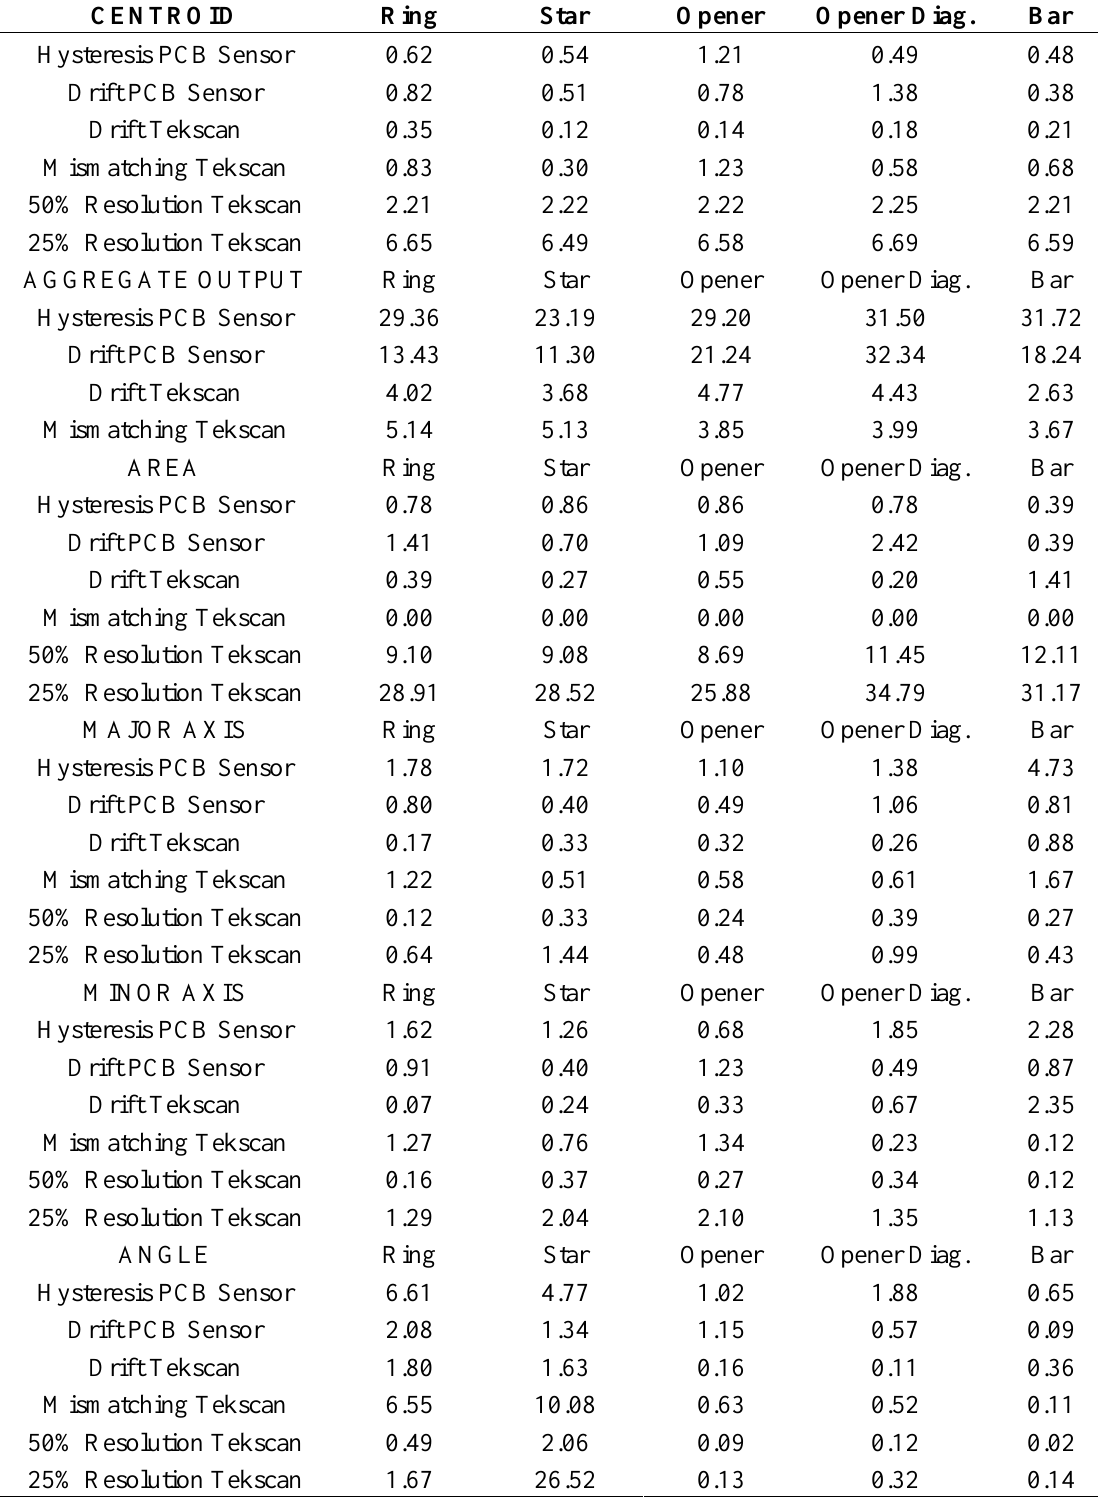
Table 10. Comparison of the influence of different non idealities on the parameters of Table 4 (percentile